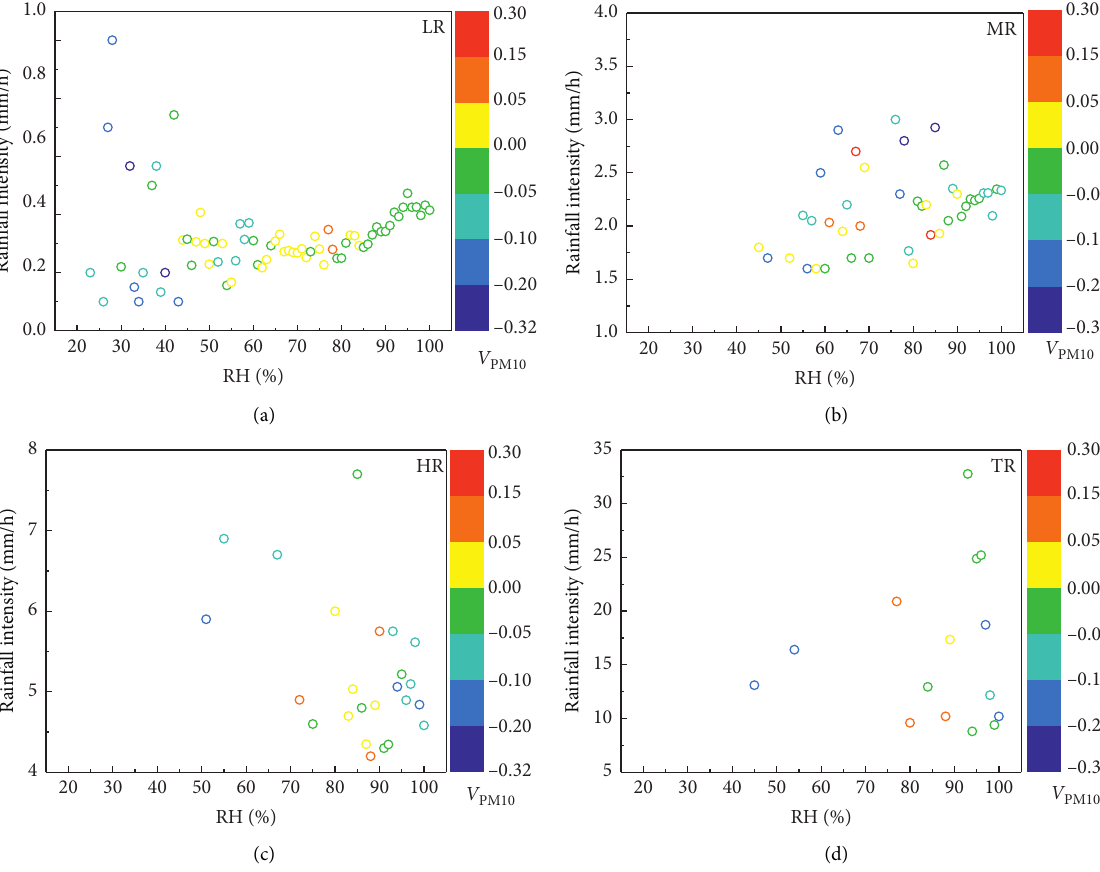
Figure 7: Distributions of V PM10 in each relative humidity range (0–100% with 1% intervals) for different levels of precipitation: (a) LR; (b) MR; (c) HR; (d)